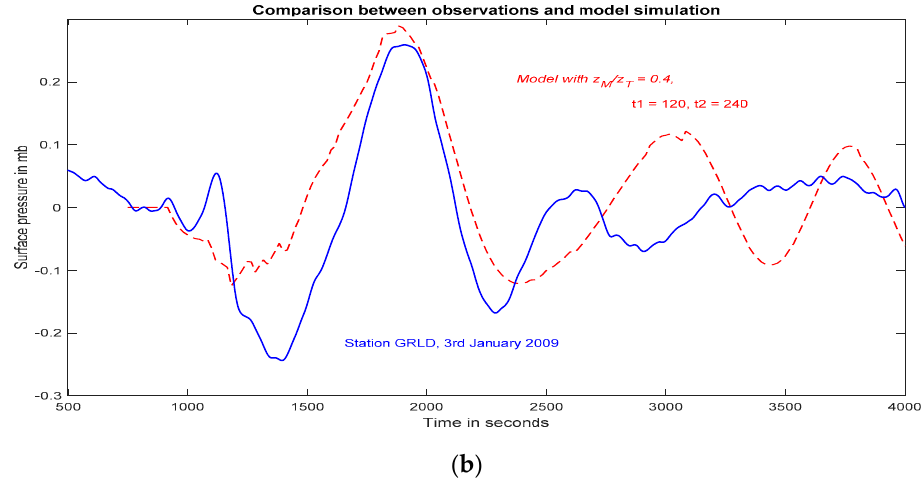
Figure 10. A comparison between observations of surface pressure variations from the eruption on Montserrat on 3 January 2009 at: ( a ) station AIRS (5 km from the source); and ( b ) station GRLD (10 km from source), and a model simulation for these distances. The curves chosen have z M / z T = 0.4, t 1 = 120 s, and t 2 − t 1 = 120 s. This implies an eruption that reached height of 5.6 km, and lasted for 4 min.